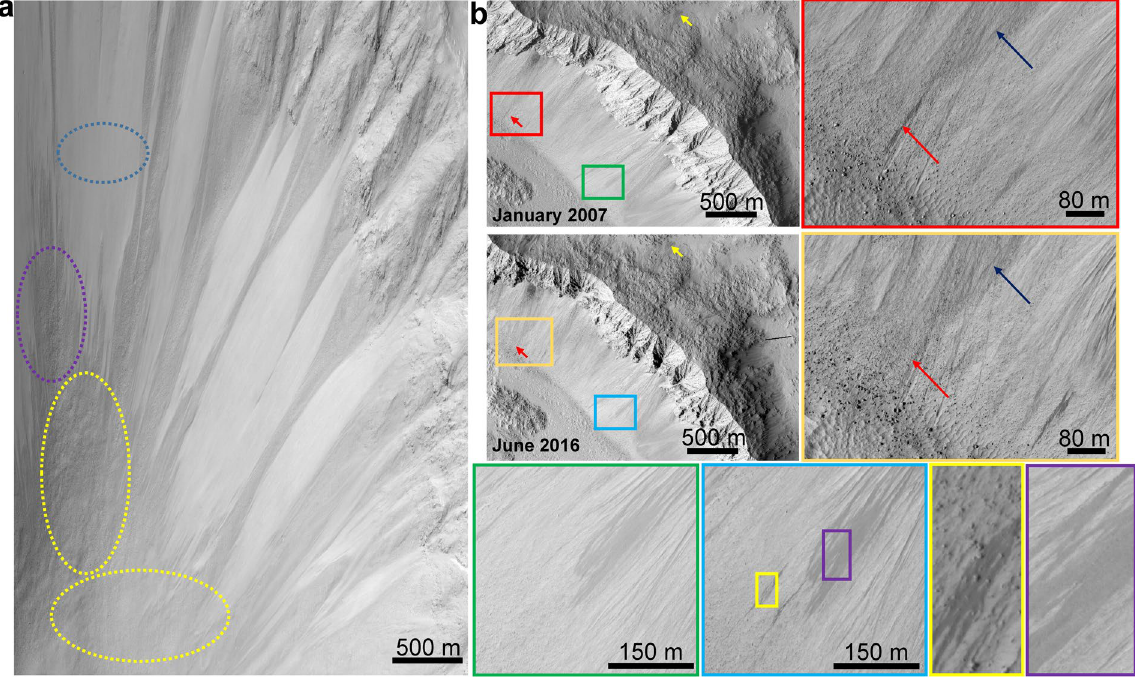
Figure 3. Difference between low-volume mass wasting and slope streaks in HiRISE images. ( a ) Scree falls and talus deposits. The blue dotted ellipse differentiates the smooth texture of these mass movements from the rough-textured bed rock (violet dotted ellipse). The yellow dotted ellipse shows the hazy texture corresponding to the downslope dust and talus deposits. ( b ) Streaks and mass wasting in Zunil Crater. The smaller red and yellow arrows in the upper left panel (January 2007) show similar albedo streaks on steep and gentle slopes, respectively. The orange rectangle in the June 2016 image shows the disappearance of the steep slope streak (in red rectangle). The blue arrows show the active mass movement slopes above the slope streak. The green and blue rectangles highlight the appearance of a new streak (marked by yellow rectangle). The yellow and violet rectangles show the difference in topography of the slope streak and the low-volume mass wasting, respectively, on the same slope. HiRISE image credit: NASA/JPL/University of